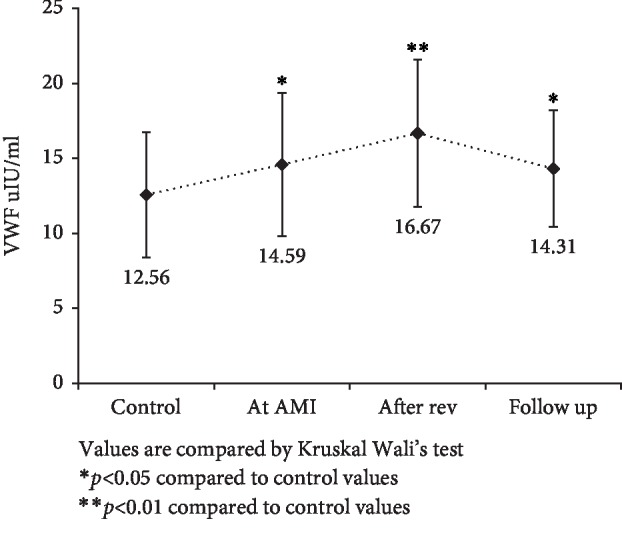
Comparison of VWF levels in control, at AMI, after revascularization and at 4–6 weeks of follow-up in AMI patients with control subjects. Values are compared by Kruskal Wallis test. ∗p < 0.05 compared to control values. ∗∗p < 0.01 compared to control values.